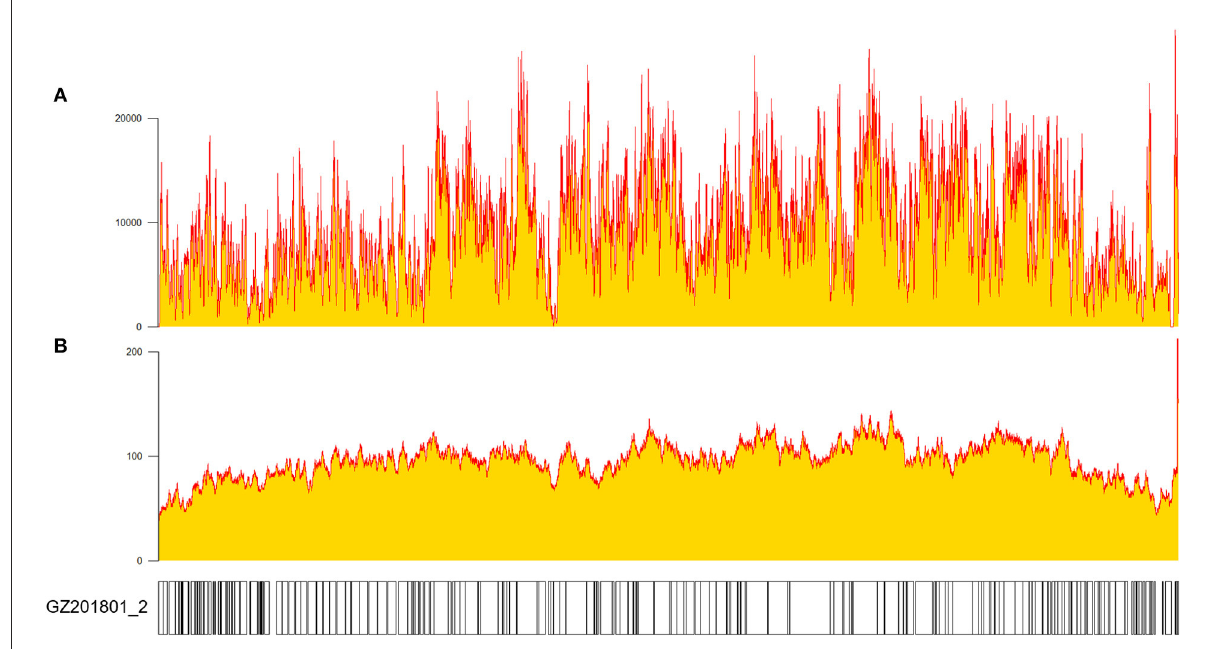
FIGURE1 Depth and coverage of GZ201801_2 measured using SAMtools v1.10 after sequencing (27). (A) MGI platform sequencing and (B) Nanopore